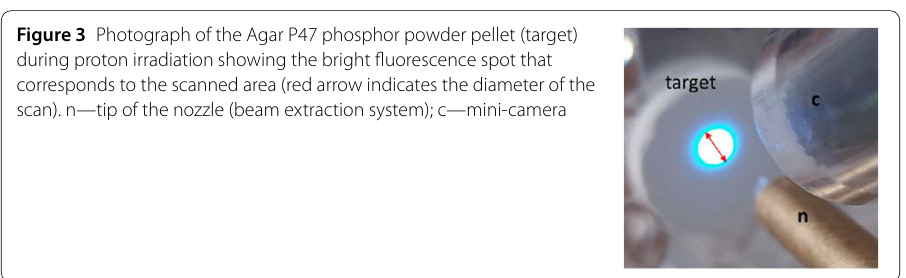
Figure 3 Photograph of the Agar P47 phosphor powder pellet (target) during proton irradiation showing the bright fluorescence spot that corresponds to the scanned area (red arrow indicates the diameter of the scan). n—tip of the nozzle (beam extraction system);